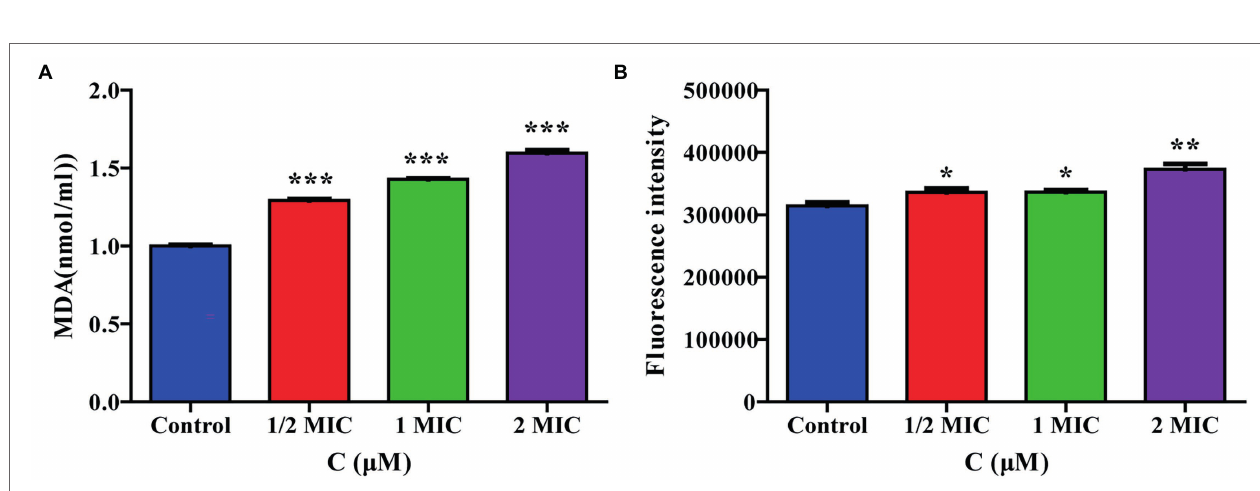
FIGURE 6 | Effect of moringin on oxidative stress apoptosis in Listeria monocytogenes . (A) MDA level activity exposure to different concentrations of moringin. (B) ROS activity exposure to different concentrations of moringin. * p < 0.05, ** p < 0.01, and *** p <